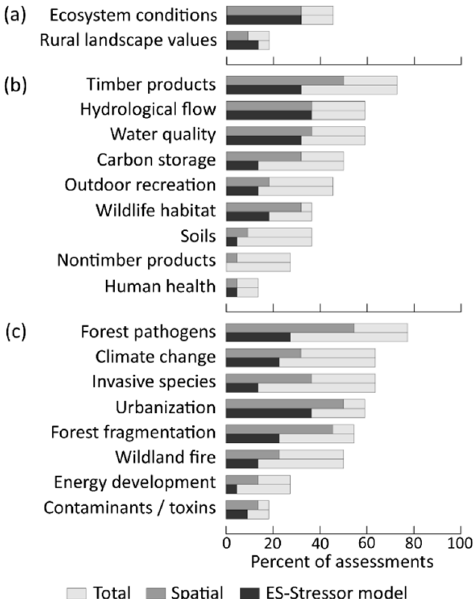
Figure 2. Categories of ( a ) ecosystem-level properties, ( b ) ecosystem services (ES), and ( c ) stressors quantified in 22 ecological assessment documents (Appendix A) that covered the Appalachian region or a significant subregion or state, and that focused on forest-based ES or resources. ‘Ecosystem conditions’ is used here to include ecosystem-level or forest-level properties encountered in assess- ment documents, including integrity, condition, health, and resilience. Specific definitions for these properties varied among documents. Total = percent of assessments in which the category was addressed quantitatively; Spatial = percent in which the category was quantified spatially at the county level or finer; ES-stressor model = percent in which a quantitative relationship expressed the effect of one or more stressor on an ES or system-level